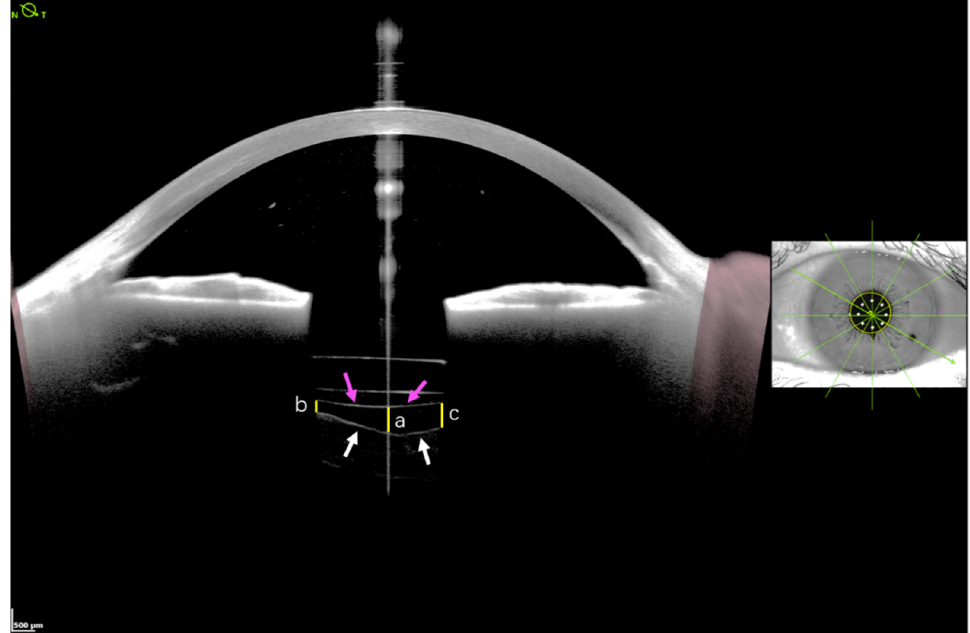
Figure 2. The measurement locations used to determine the width of Berger’s space. The width of Berger’s space, defined as the vertical distance between posterior lens capsule (pink arrows) and anterior vitreous hyaloid (white arrows), was manually measured at three points of each scanned meridian line: the central point line ( a ) and the two point lines ( b , c ) at the margins of the pupil (yellow solid lines).